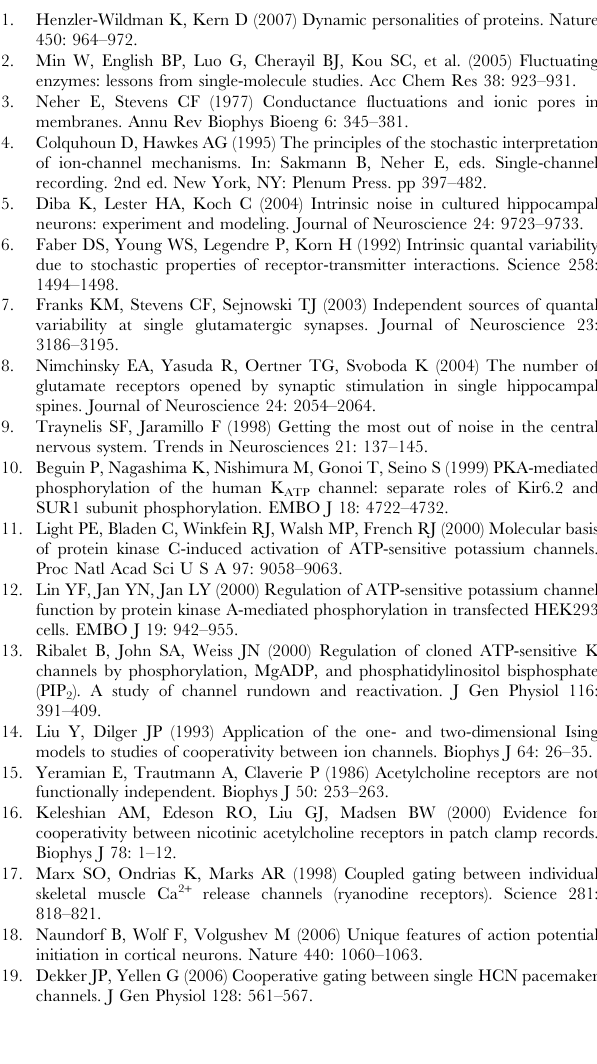
Table S1 Observed time constants when the faster closing rate constant